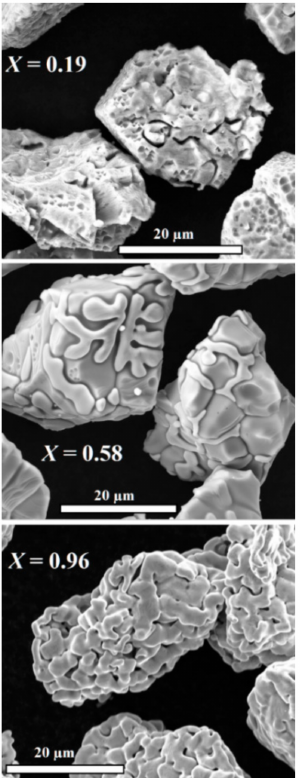
Figure 2. SEM micrographs of particles at 1137–1324 ◦ C. ( X is fractional conversion.) (The figure is adapted from [39], with permission from John Wiley & Sons, 2017).